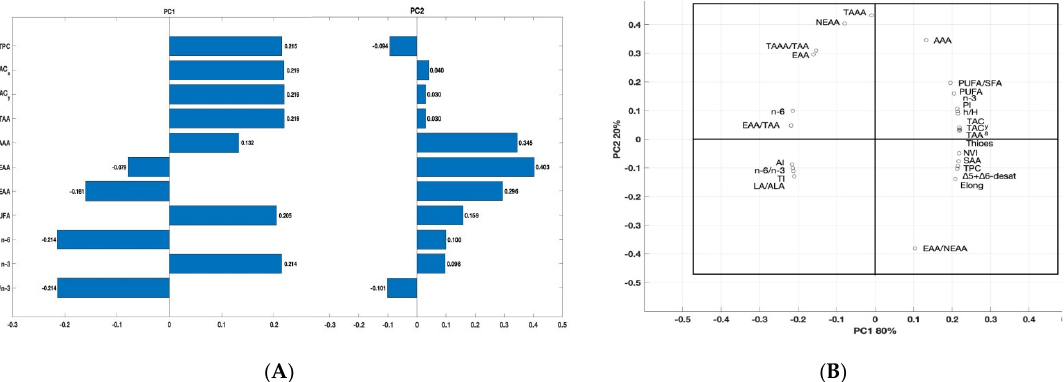
Figure 4. Results of the principal component analysis (PCA) for selected parameters of the egg yolks obtained from hens in the RF0, RF1, and RF2 groups, determined at the end of the study. ( A ) Partial sums of correlation between total polyphenol content (TPC), total antioxidant capacity in albumen (TAC_a) and yolk (TAC_y), sums of PUFA, n ‐ 3, n ‐ 6, n ‐ 6/ n ‐ 3 ratio, total amino acids (TAA), antiox ‐ idant amino acids (AAA), non ‐ essential amino acids (NEEA) and essential amino acids (EAA) of the egg yolks obtained from hens in the RF0, RF1 and RF2 groups, determined at the end of the study. ( B ) PCA bi ‐ plot (loading plot) for the PC1 and PC2 components. PC1 covered 80% of the variance and PC2 covered 20% of the variance. The first principal component PC1 (eigenvalue: 3.66) explained most of the variabil ‐ ity of the data (80%) and was significantly negatively associated with NEEA, EAA, n ‐ 6, and n ‐ 6/n ‐ 3 (correlation − 0.0079, − 0.191, − 0.871, and − 0.871, respectively) and positively correlated with TAC_y, TAC_a, TPC, TAA, AAA, PUFA and n ‐ 3 (Figure 4A). The second component PC2 (eigenvalue: 1.44) explained less of the variance (20%) and was only neg ‐ atively correlated with TPC (correlation: − 0.014) and n ‐ 6/n ‐ 3 (correlation: − 0.101). As the eigenvalue of PC2 was above 1, meeting Kaiser’s criterion of inclusion, a Cattell’s scree plot was performed to confirm that the usage of PC2 was appropriate. PCA loading plot for the first two components, which combined explain 100% of the variation of the data, showed that there was significant variability among calculated protein and lipid health ‐ related indices (Figure 4B). 4. Discussion 4.1. Chemical Composition of the Rosehip and Flaxseed Meals The nutritional composition, antioxidant compounds, fatty acid profile, and amino acid content in rosehip and flaxseed meal highlighted that both supplements have varia ‐ ble concentrations of these nutrients. Flaxseed meal presented high concentrations of crude protein and crude fat, while rosehip was noted to have a high concentration of crude fiber, which limits its usage in poultry diets. As it is well known, flaxseed meal proved to have a high concentration of n ‐ 3 PUFA, especially ALA, being more than three times higher than that determined in rosehip meal. The lowest ratio of n ‐ 6 to n ‐ 3 was also de ‐ termined in flaxseed meal. In terms of AA content, flaxseed meal was dominant for the